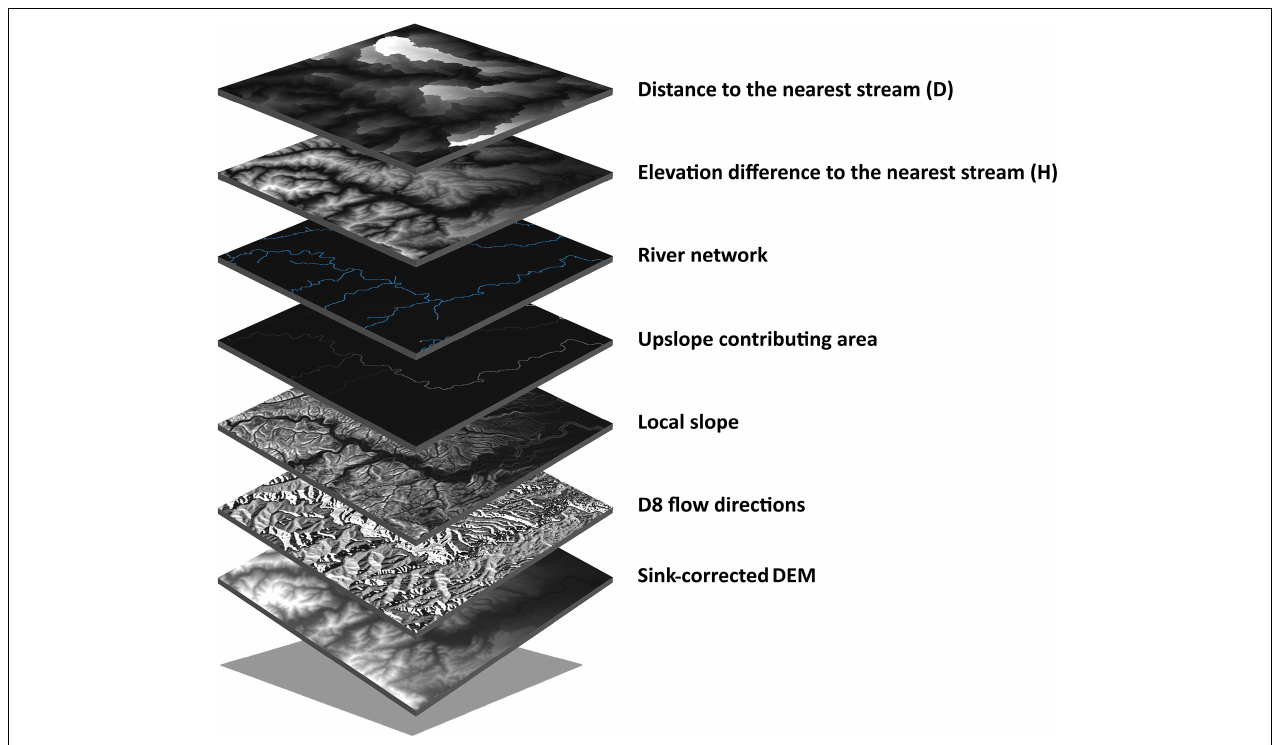
FIGURE 3 | Layers involved in the extraction of terrain descriptors from digital elevation models